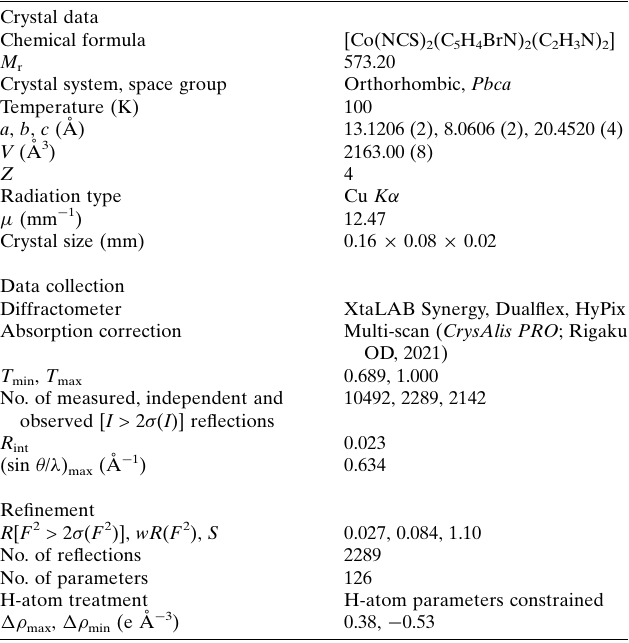
Table 3 Experimental details. Crystal data Chemical